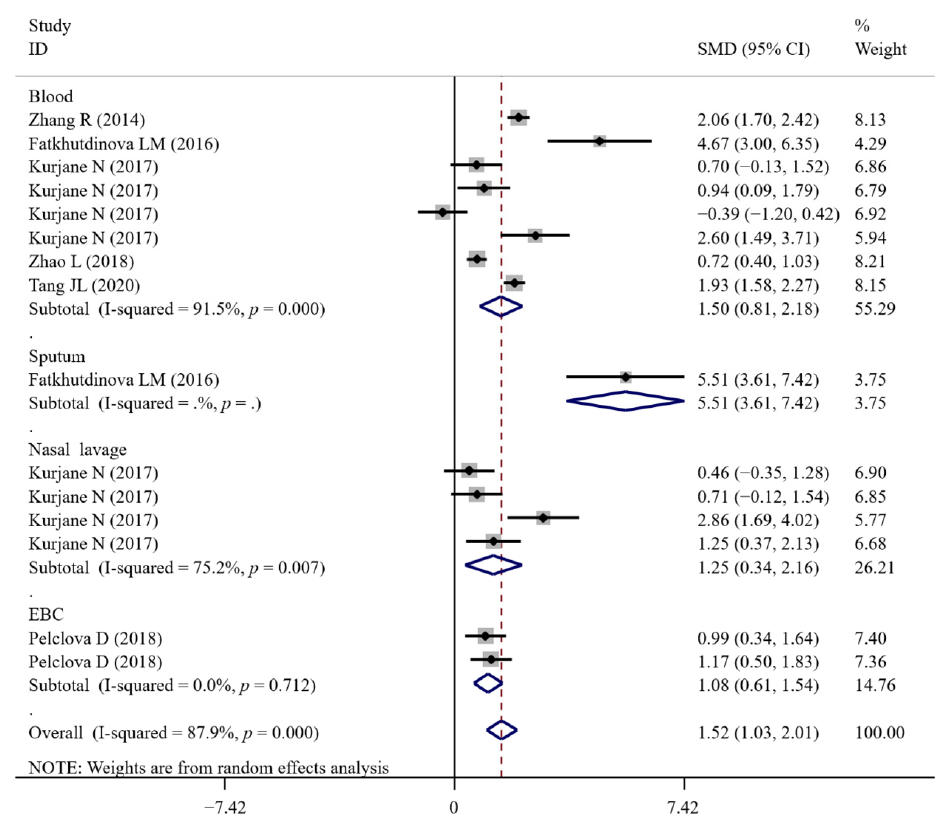
Figure 11. Forest plots assessing the effects of NM exposure on the level of TNF- α in different samples compared with the non-exposed control group. NMs, nanomaterials; EBC, exhaled breath condensate; TNF- α , tumor necrosis factor- α ; SMD, standardized mean difference; CI, confidence interval [17,19,25,36,39,40].